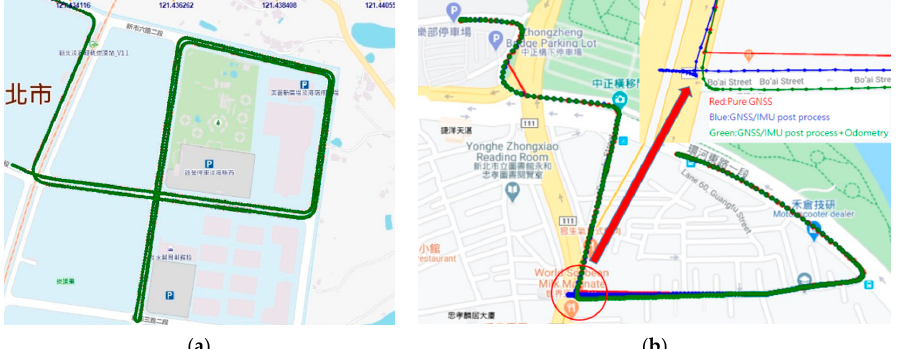
Figure 5. ( a ) Position trajectories in open area; ( b ) Position trajectories in urban area. Red: Pure GNSS position is unreliable, Blue: A post process integrating the IMU is used to reduce the position error, Green: Speed information is considered in the post-process to further reduce the position error as indicated in the red circle.